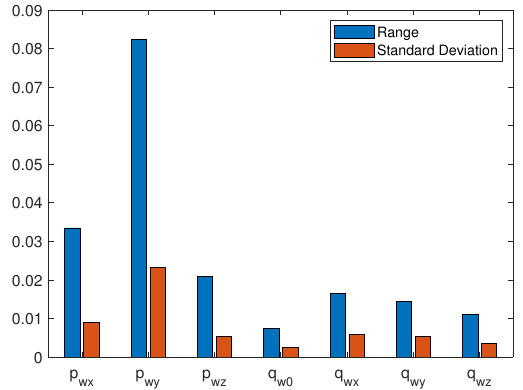
Figure 13. Average range and standard deviation for each